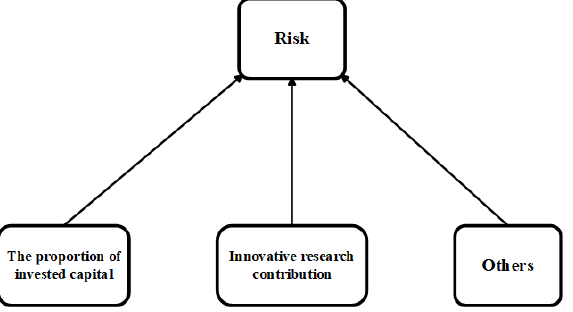
Figure 4. Three identified risk